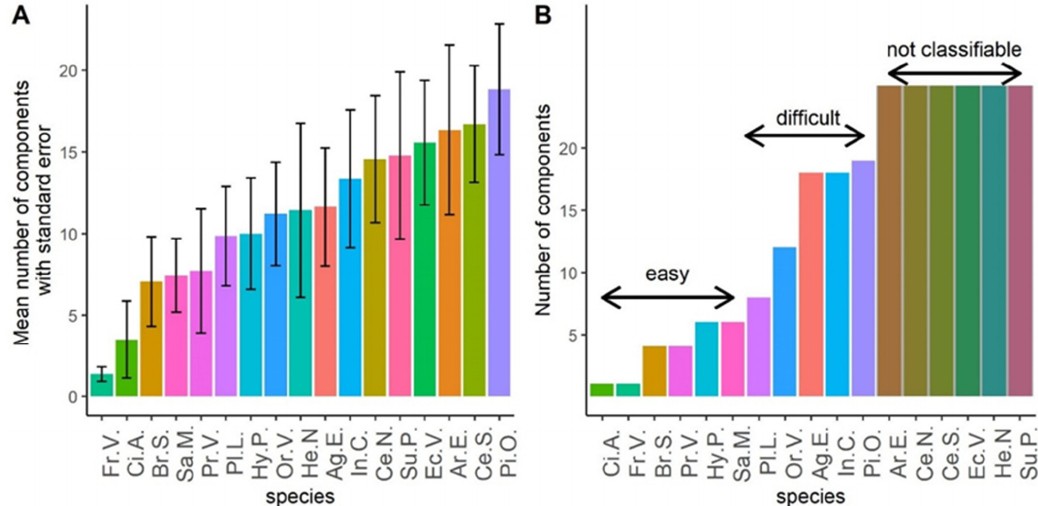
Figure 8. The “ease” of classification, defined as the number of components (latent variables) produced from the sPLS-DA models that were required to classify a species to a <10% error rate. Species are ranked from easiest to hardest to classify (left to right); ( A ) the mean and SE of the models across sampling dates; ( B ) the results from the model that was trained using the cross-seasonal dataset. Shaded bars show the species that were not classifiable to the required error rate.